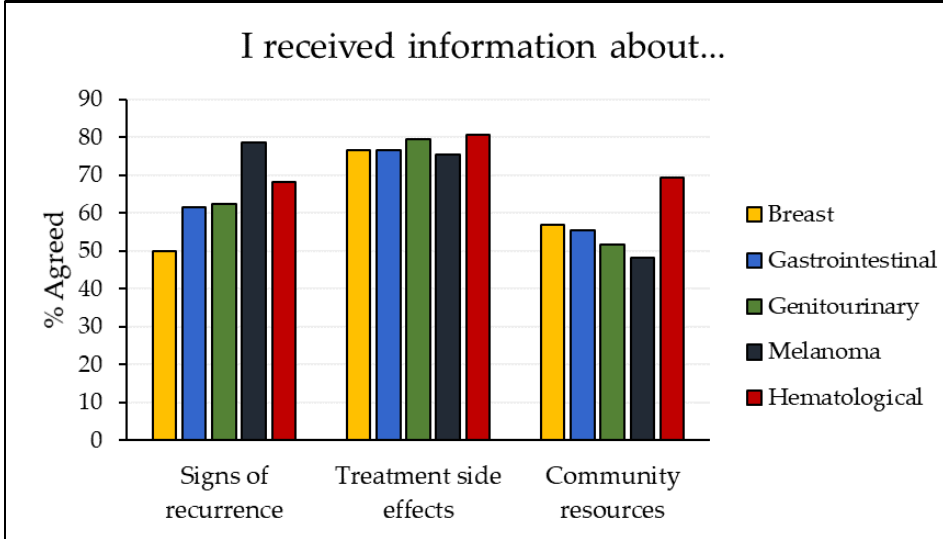
Figure 1. Information after Completing Cancer Treatment (by tumour group).